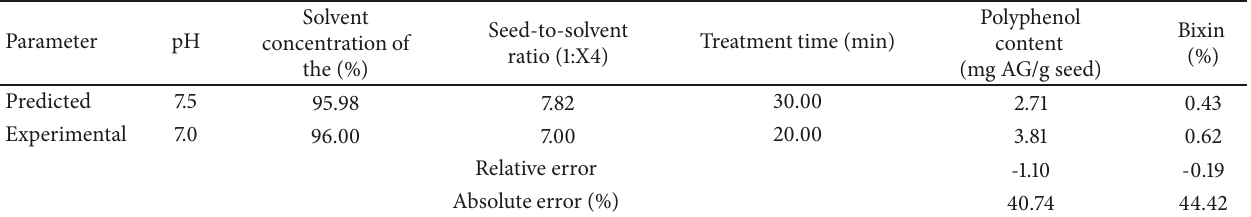
Values are expressed as mean ± standard deviation (n = 3). AG: gallic